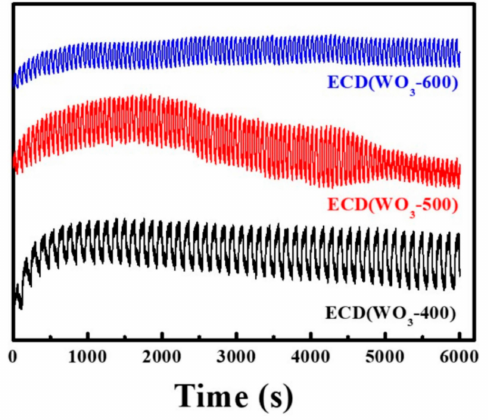
Figure 10. Circulating map of tungsten oxide foil prepared at different calcination temperatures for electrochromic devices, applied voltage: ± 3.0 V; WO 3 -400 cycle time is 120 s; WO 3 -500 and WO 3 -600 cycle time are 60